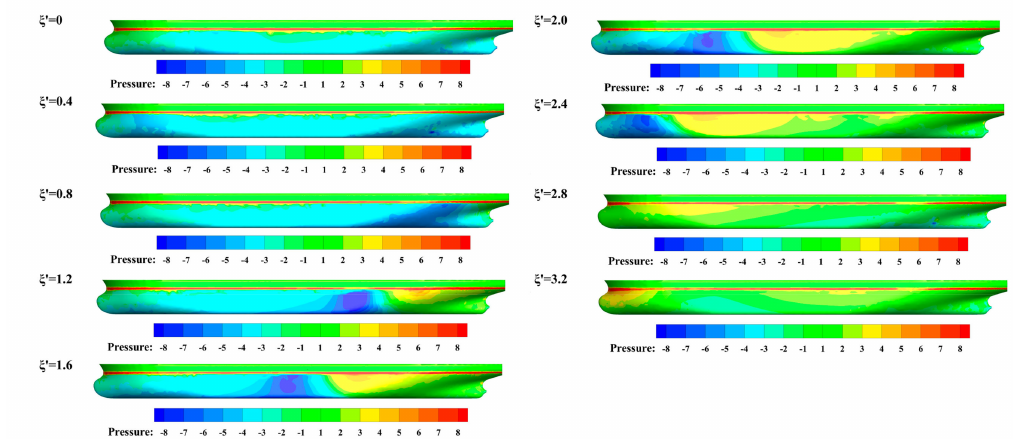
Figure 12. The dynamic pressure distribution on the left DS hull surface, ξ (cid:48) = 0,K,3.2.